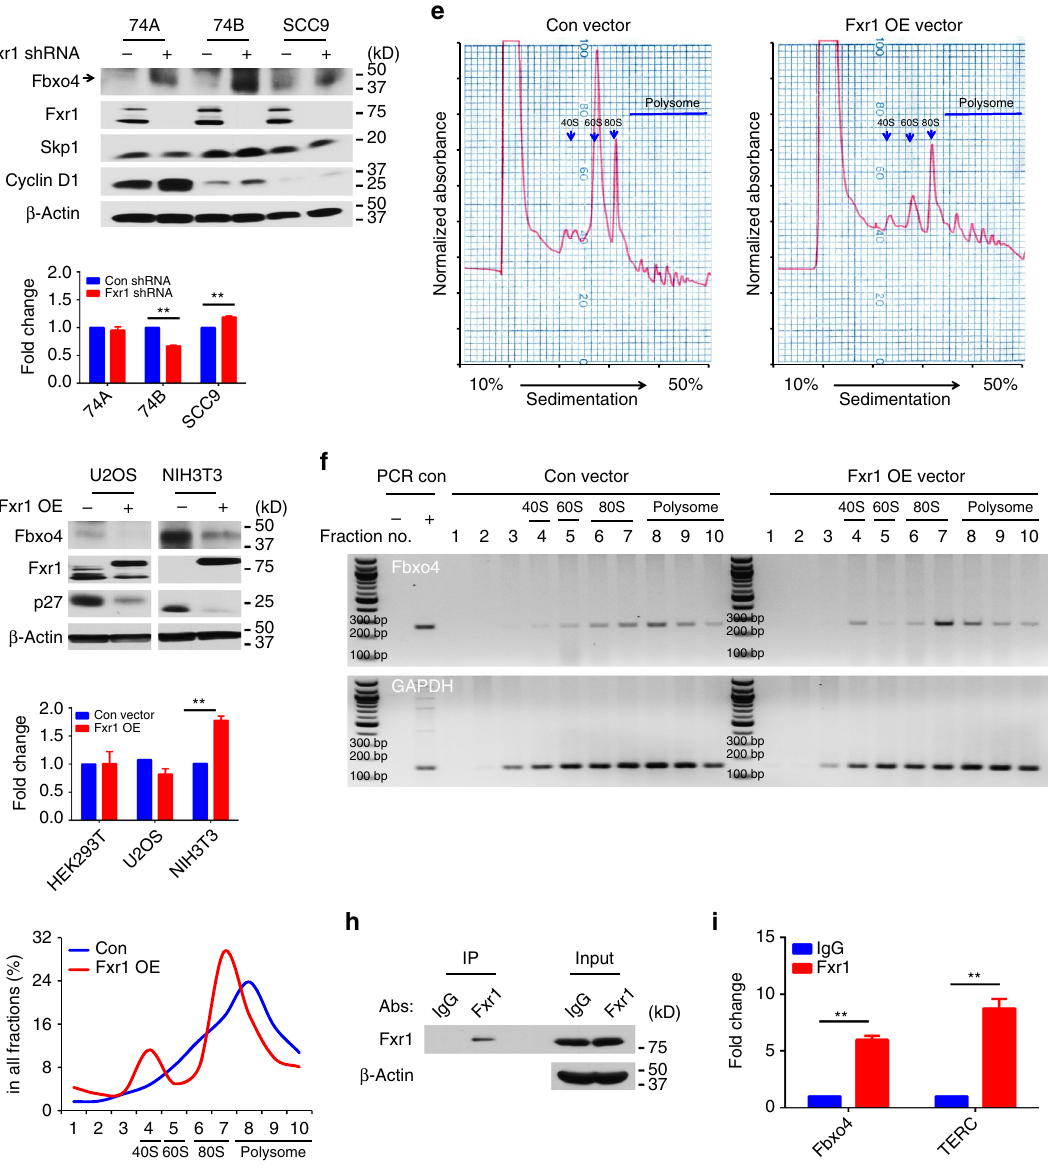
Fig. 6 Negative feedback regulation of Fbxo4 by Fxr1. a Fbxo4 protein levels upon Fxr1 knockdown in 74A, 74B and SCC9 cells. b Fbxo4 mRNA levels upon Fxr1 knockdown in 74A, 74B and SCC9 cells. c Fbxo4 protein levels upon ectopic Fxr1 expression in U2OS and NIH3T3 cells. d Fbxo4 mRNA levels upon ectopic Fxr1 expression in HEK293T, U2OS and NIH3T3 cells. e Polysome pro fi le in NIH3T3 cells with Fxr1 overexpression. f DNA gel shows the RT-PCR products from serial polysome fractions. g Quantitative distribution of Fbxo4 mRNA from ( f ). h Western blot from immunoprecipitation of Fxr1 in RIP analysis. i RIP analysis indicates Fxr1 interacts with Fbxo4 mRNA. TERC mRNA is used as positive control. All the data represent mean ± s.d. and were analysed by Student ’ s t test ( n = 3). ** p <